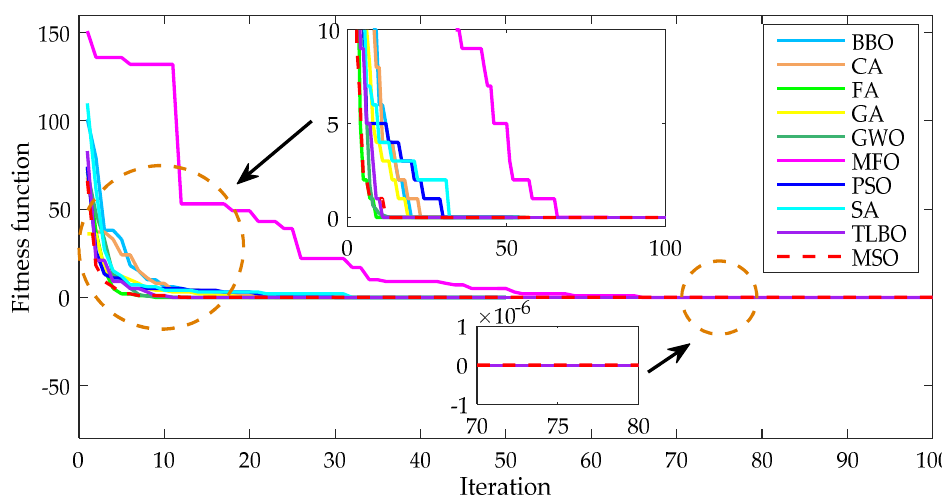
Figure 7. Comparison of convergence curves of ten algorithms in a discontinuous step test function.